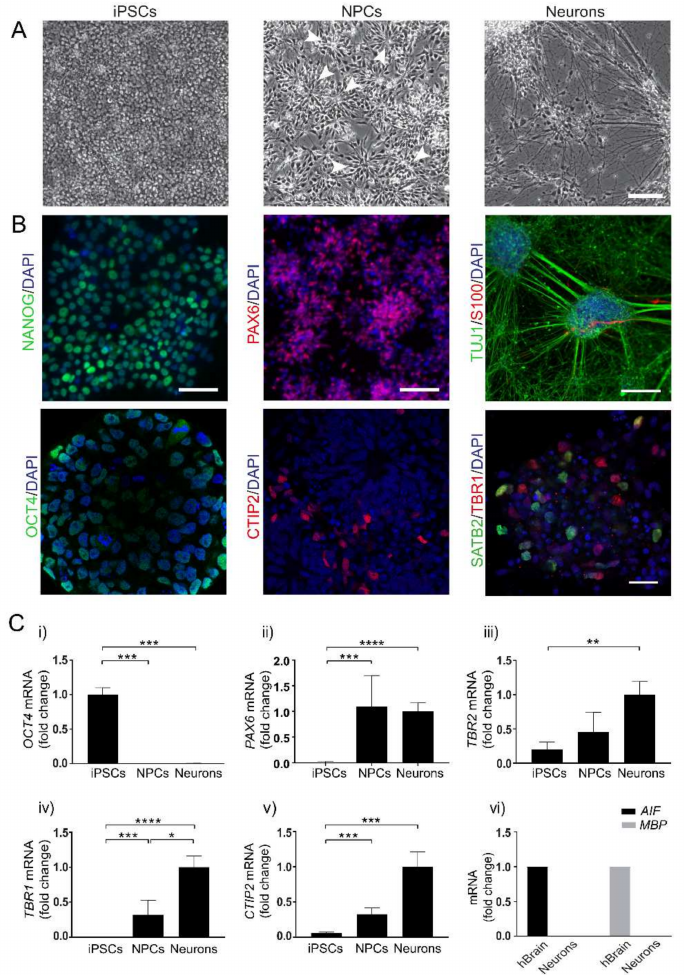
Figure 1. Differentiation of human iPSCs towards cortical neurons. ( A ) Representative phase contrast images showing cell morphology of human induced pluripotent stem cells (iPSCs) before differen- tiation, neuroprogenitor cells (NPCs) forming cortical rosette structures (arrows) after 30 days of differentiation and cortical neurons (Neurons) forming neurite networks after 90 days of differentia- tion. Scale bar = 100 µ m. ( B ) Representative confocal images from immunocytochemistry staining of cells during neuronal differentiation; iPSCs stained positive for the stem cell markers NANOG (green, left upper panel) and OCT4 (green, left lower panel). In the NPC cultures, the cortical rosettes stain positive for primary progenitor marker PAX6 (red, upper mid-panel), and CTIP2-positive layer-V neurons (red, lower mid-panel) start to appear around the edges of the cortical rosettes. After three months of differentiation, immunocytochemistry staining of neuron-specific tubulin (TUJ1, green) shows extensive neurite networks in neurons, with a small fraction of S100-positive astrocytes (red) appearing (right upper panel). At this point, the cultures contain both TBR1-positive layer-VI neurons (red) and SATB2-positive upper-layer neurons (green) (right lower panel). Scale bar = 100 µ m for TUJ/S100B, 50 µ m for NANOG and PAX6 and 25 µ m for remaining images. DAPI-stained nuclei are shown in blue. ( C ) qPCR analysis of differentiation markers shows expression of the pluripotency marker OCT4 in iPSCs but not in NPCs or Neurons (i). Gene expressions of PAX6 (primary neuron progenitors) (ii), TBR2 (secondary neuronal progenitors) (iii), TBR1 (layer VI neurons) (iv) and CTIP2 (layer V neurons) (v) are all present in NPCs and increase with differentiation. Bars represent mean of four separate differentiations for iPSCs and three separate differentiations for NPCs and neurons from two iPSC lines +/ − SEM. * p < 0.05, ** p < 0.01,*** p < 0.001 and **** p < 0.0001 with Mann–Whitney U test. (vi) Markers for microglia (AIF1) and oligodendrocytes (MBP) were detected with qPCR in cDNA from human brain but not in cDNA preparations from cultured neurons ( n =